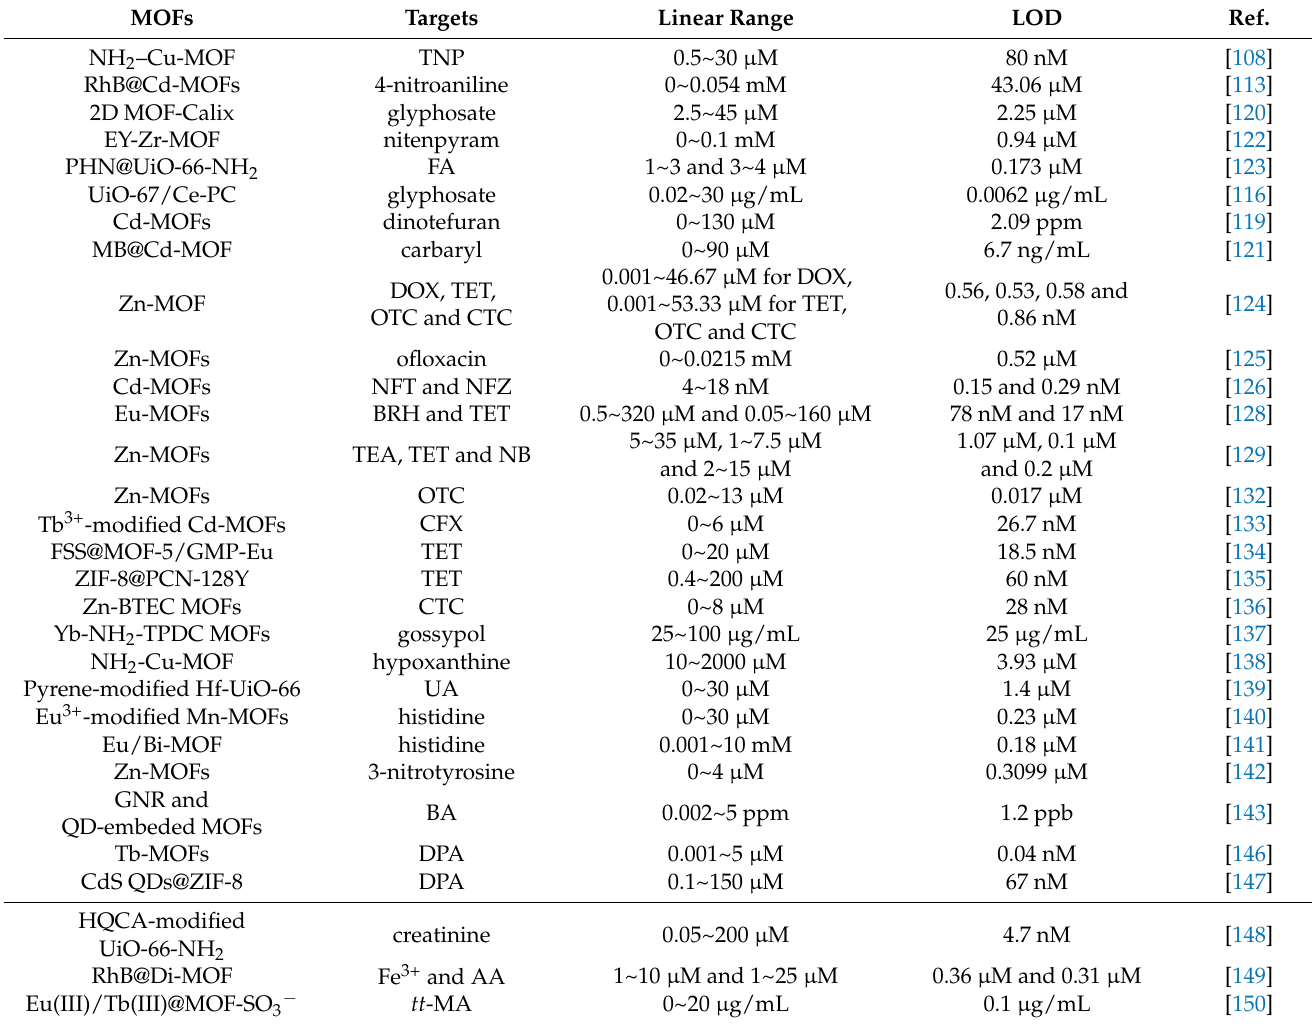
Table 2. Performances of MOFs-based fluorescent chemosensors for the detection of small organic